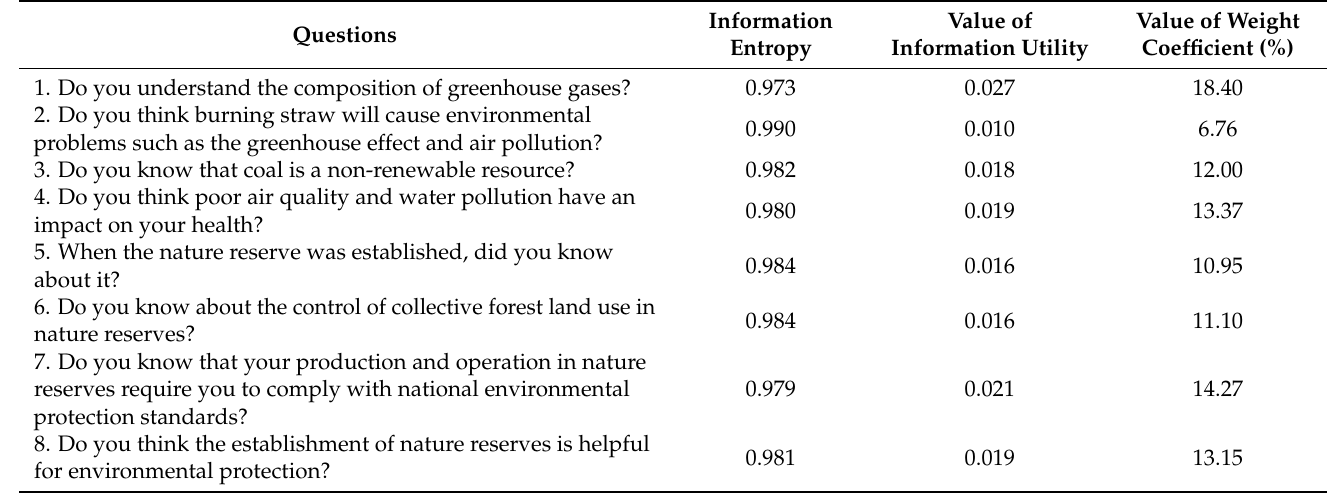
Table 2. Entropy coefficient values for the environmental cognition of the